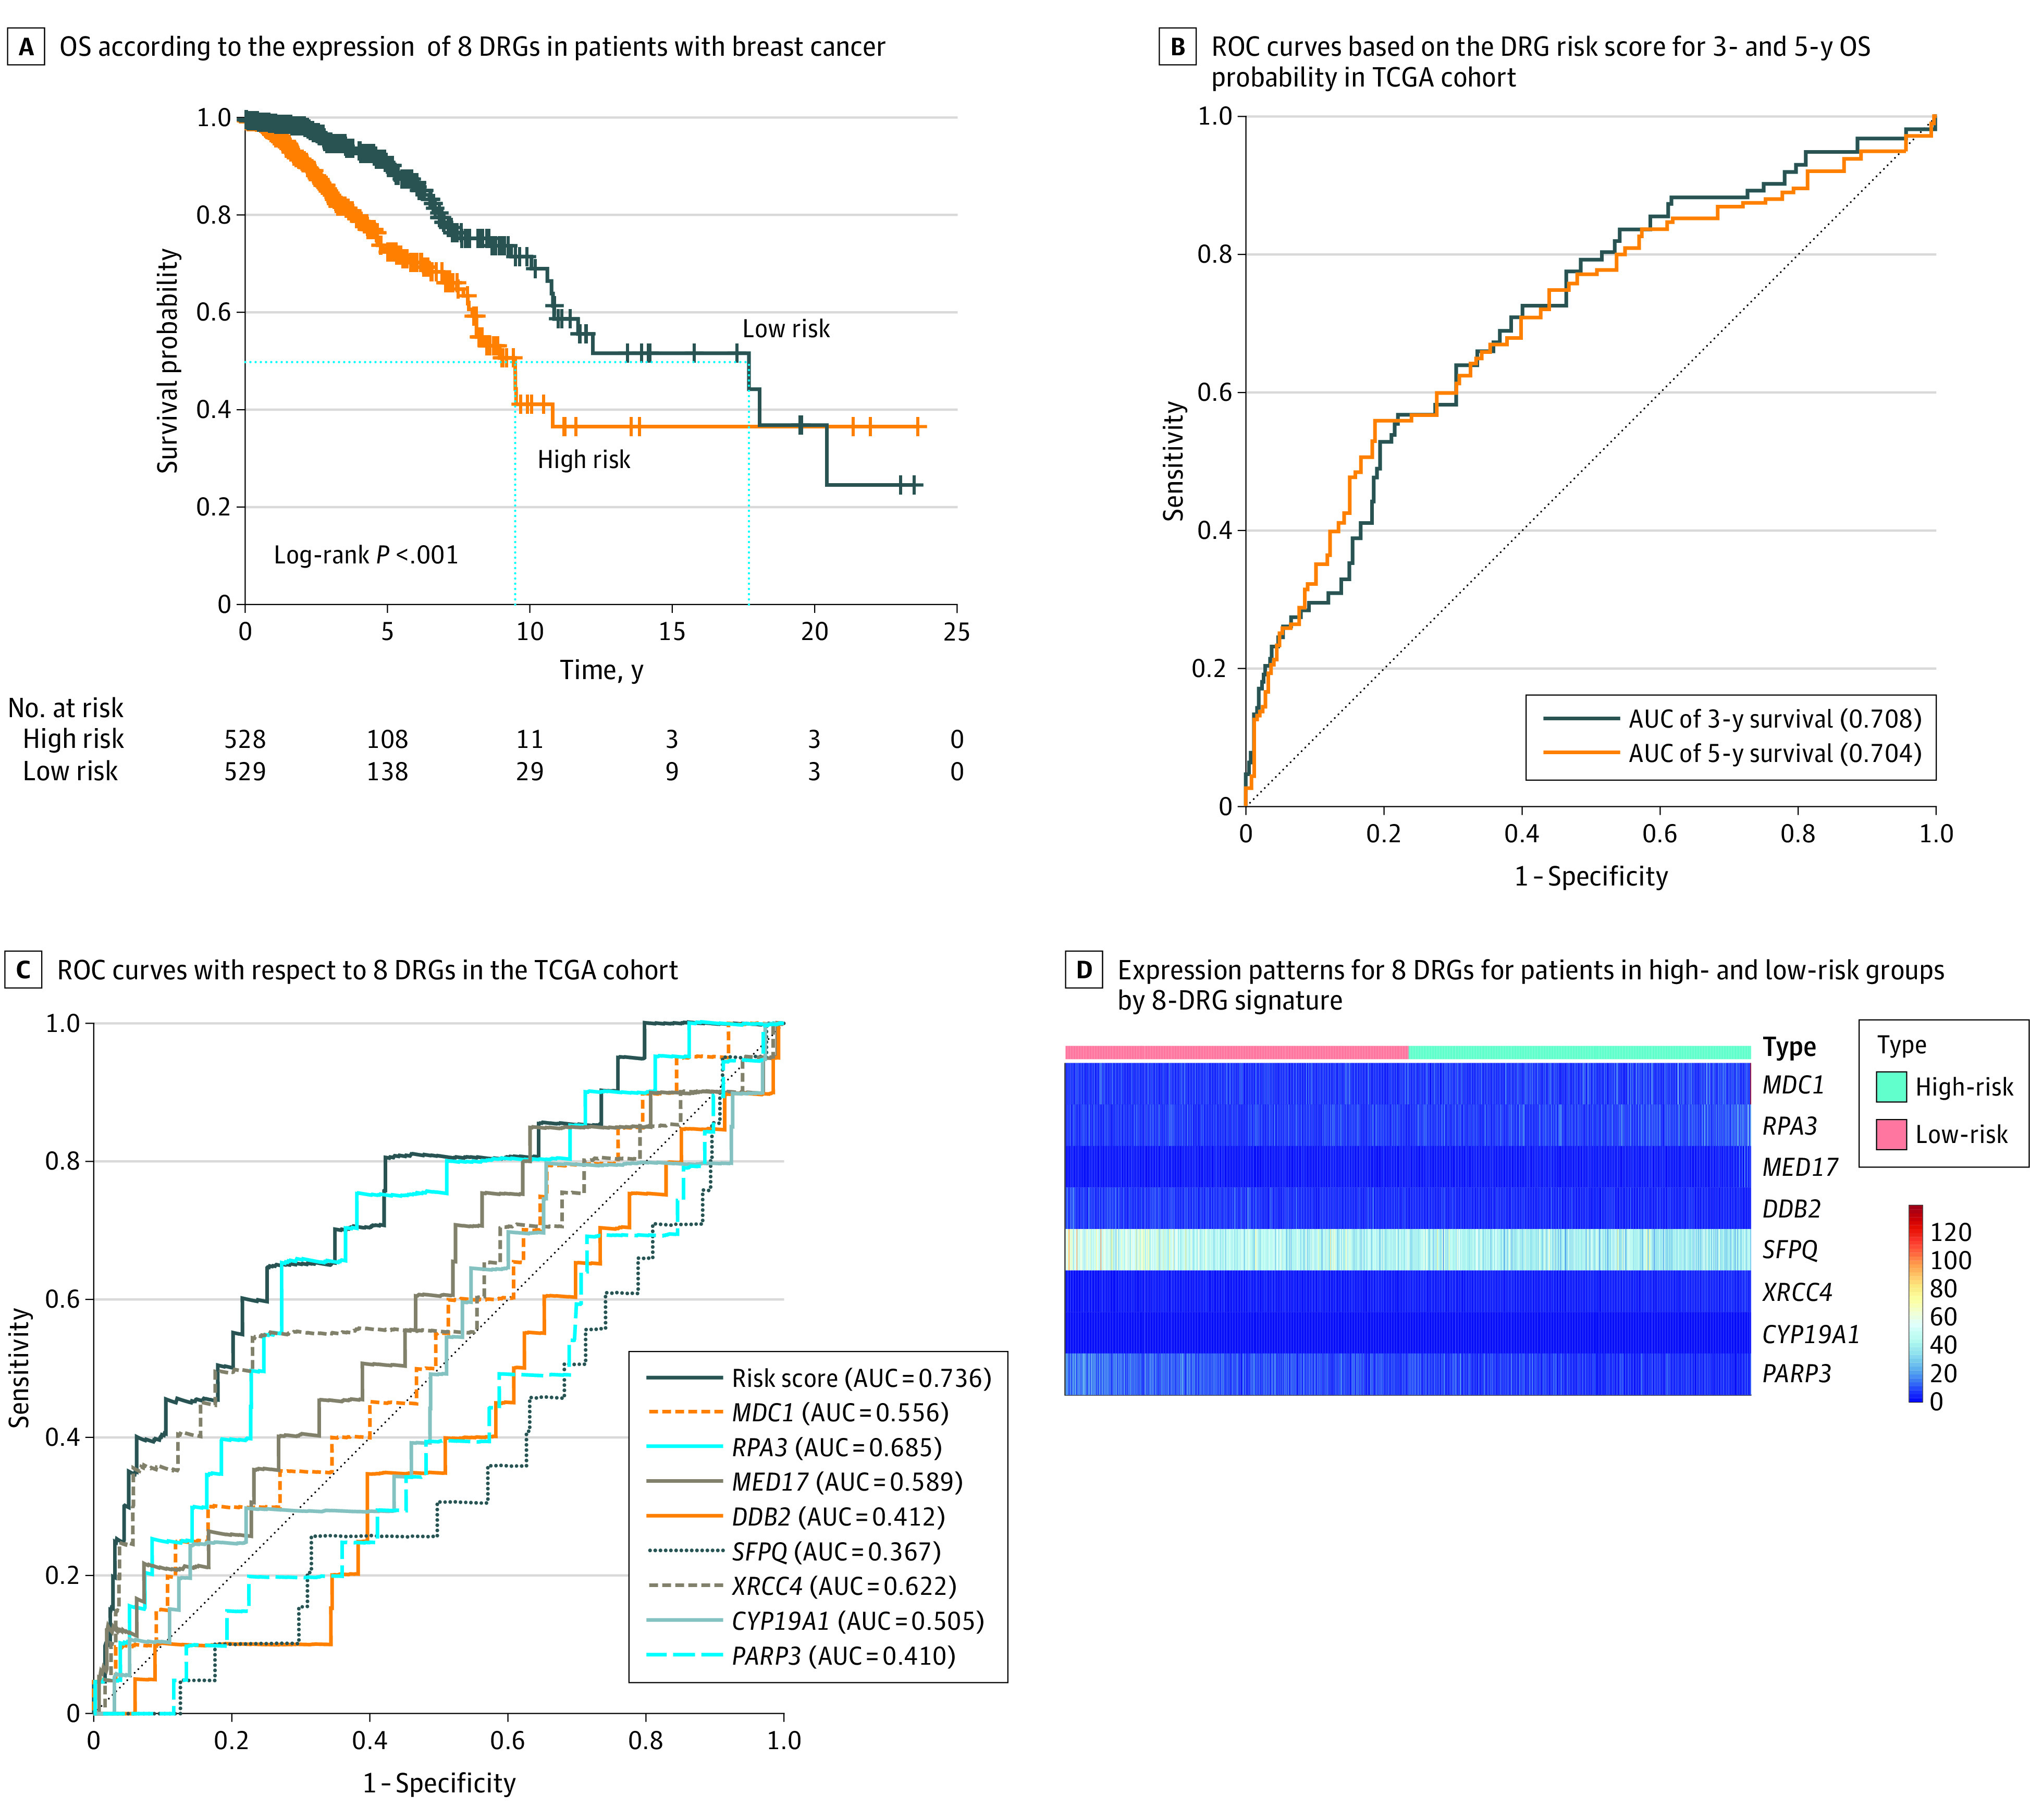
Prognostic Role of the Signature Using 8 DNA Repair–Related Genes (DRGs) in the Training SetA, Kaplan-Meier plots of overall survival (OS) according to the expression of 8 key DRGs in patients with breast cancer. B, Receiver operating characteristic (ROC) curves based on the DRG risk score for 3- and 5-year OS probability in The Cancer Genome Atlas (TCGA) cohort. C, ROC curves with respect to 8 key DRGs in the TCGA cohort. D, Expression patterns for DRGs for patients in high- and low-risk groups by the 8-DRG signature. AUC indicates area under the curve.